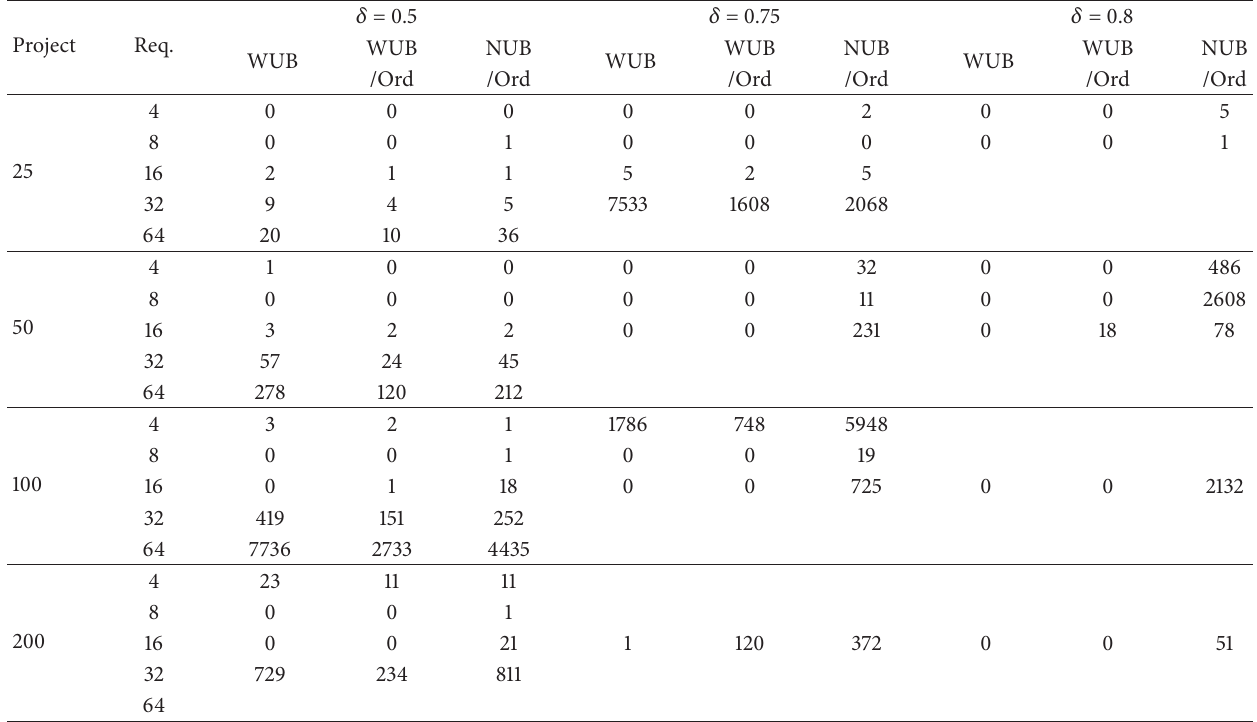
Table 2: Performance of algorithms in (ms), including sorting process WUB/Ord and NUB/Ord.